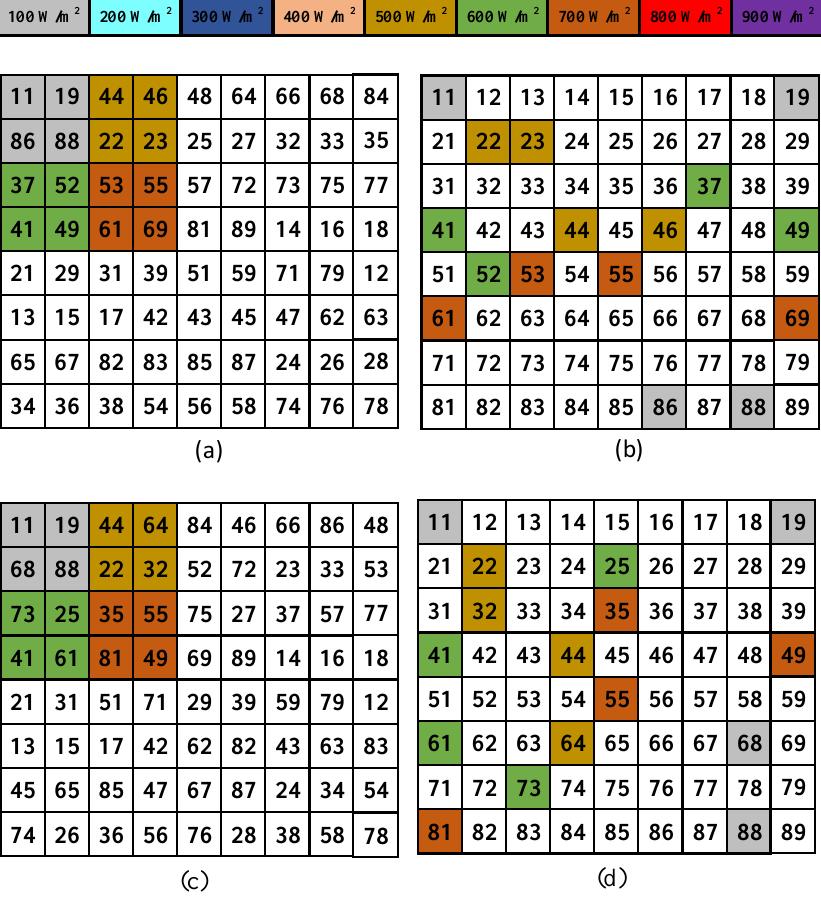
Figure 16. ( a ) OEP; ( b ) shade dispersion of OEP; ( c ) IOEP; ( d ) shade dispersion of IOEP for 8 × 9 PV array at Top-Left PSC.